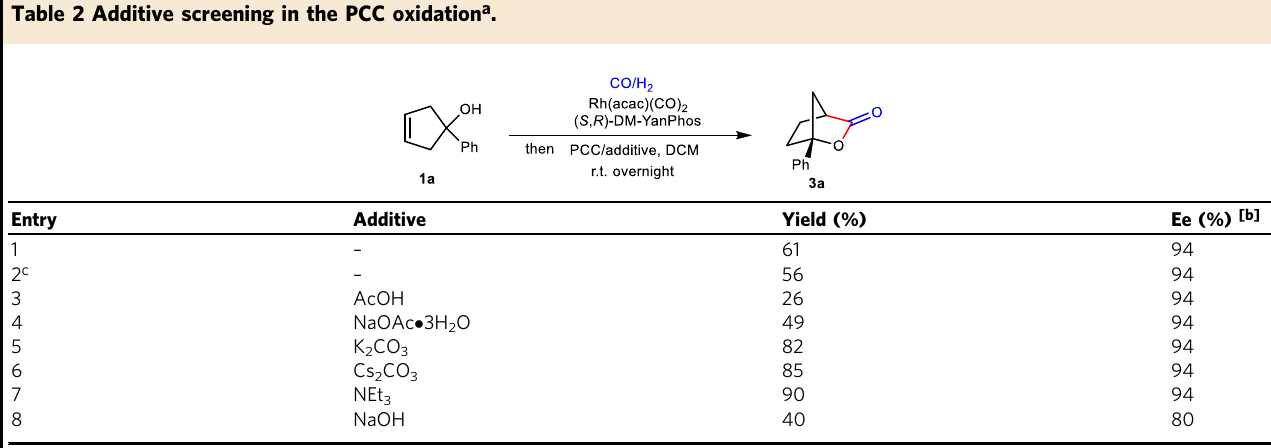
Table 2 Additive screening in the PCC oxidation a